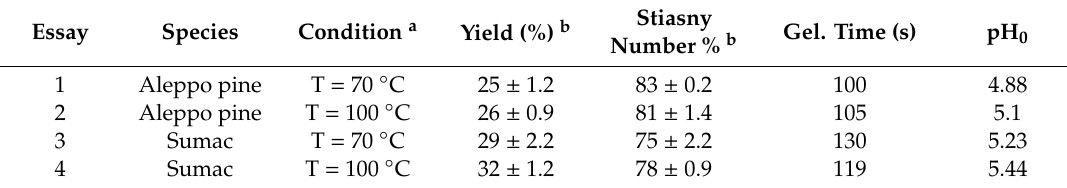
Table 1. The yield, gelation time (Tg), Stiasny number, total polyphenols of the different extracts from plant. Essay Species Condition a Yield (%)